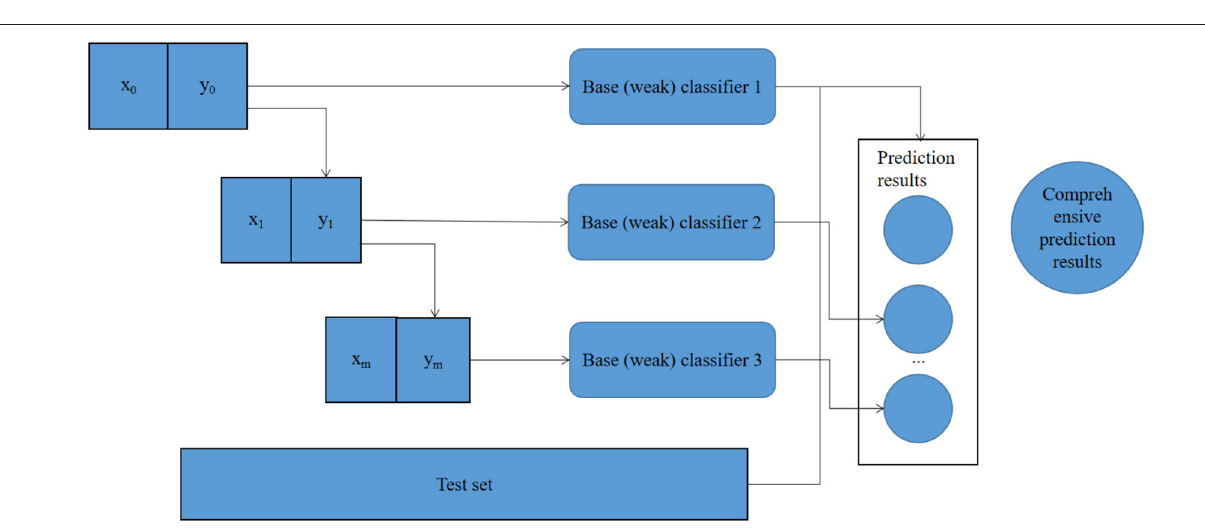
FIGURE 2 | Training flow chart of logistic regression algorithm